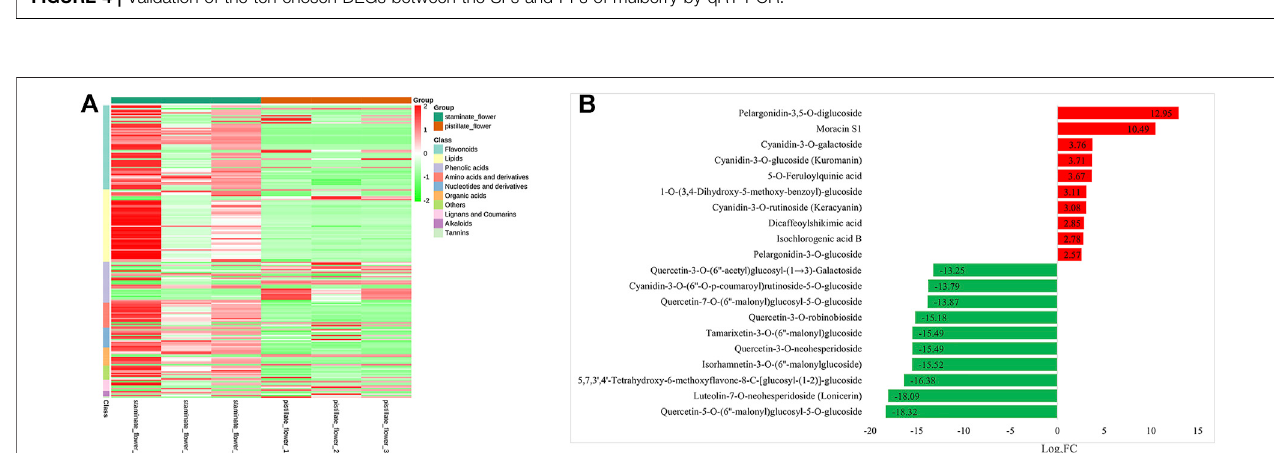
FIGURE 4 | Validation of the ten chosen DEGs between the SFs and PFs of mulberry by qRT-PCR.